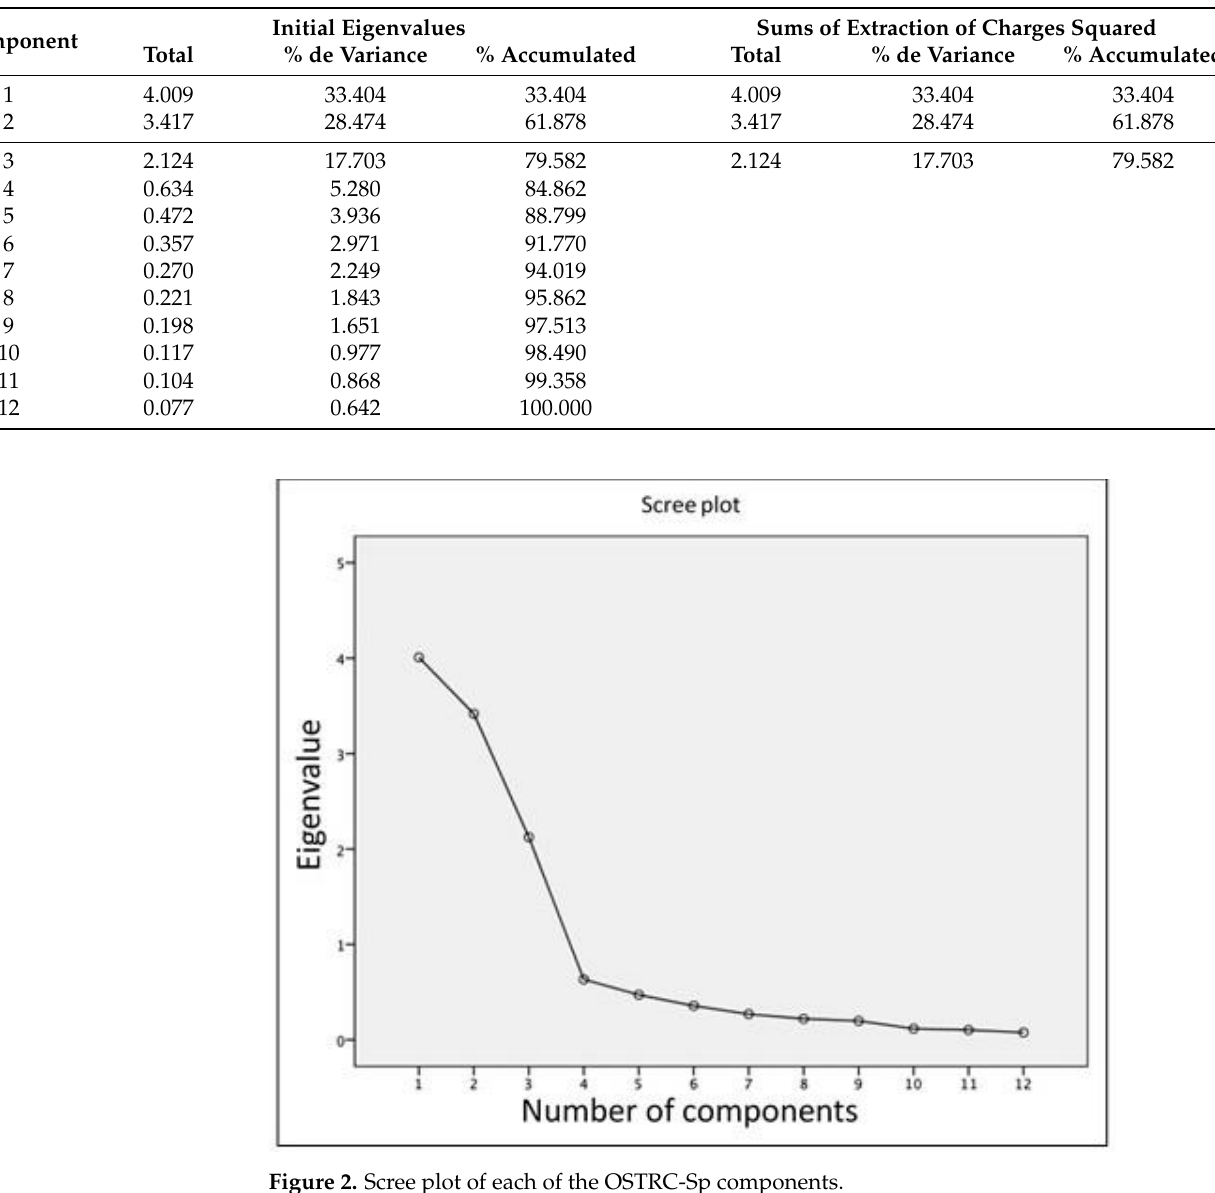
Table 3. Results of the explained variance analysis of each of the items in which the OSTRC-Sp is structured.